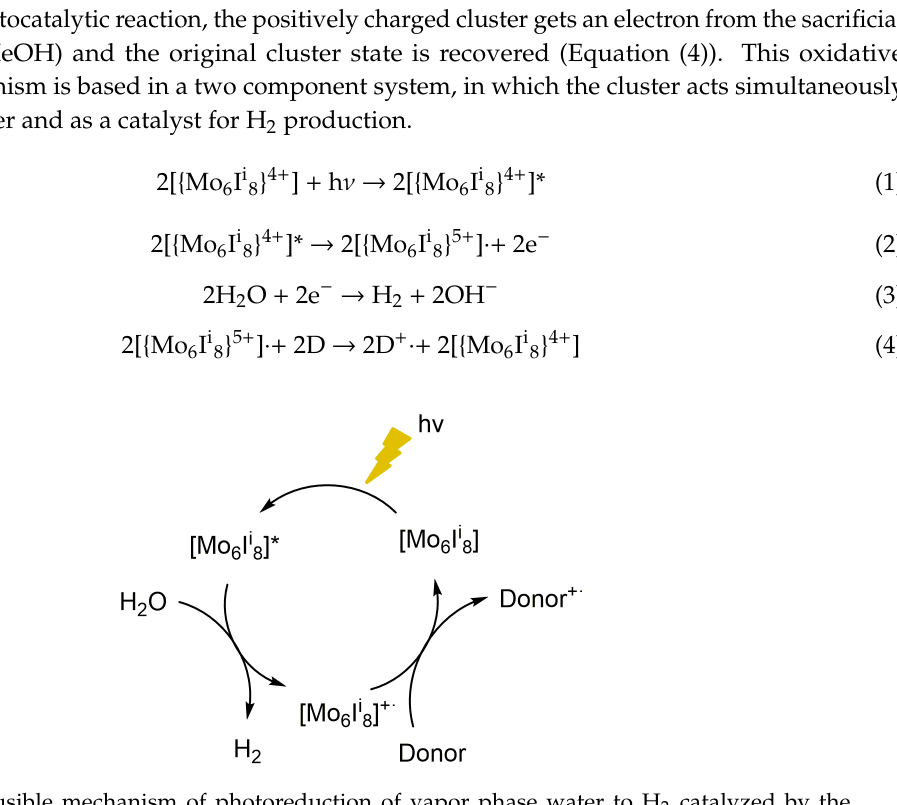
Figure 9. Plausible mechanism of photoreduction of vapor phase water to H 2 catalyzed by the molybdenum cluster units of (TBA) 2 [Mo 6 I i 8 (O 2 CCH 3 ) a 6 ] and (TBA) 2 Mo 6 I i 8 @GO catalysts.